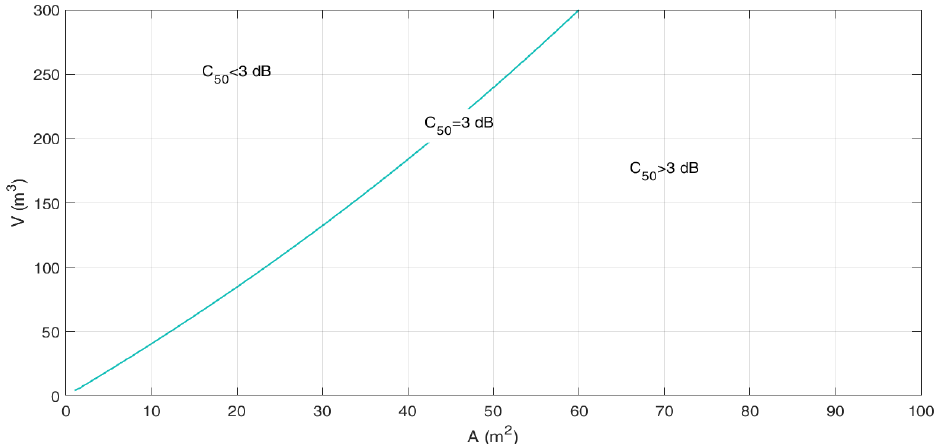
Figure 4. Prediction A – V Diagram: contour line for C 50 = 3 dB, which divides the graph into two zones, one for C 50 < 3 dB and the other for C 50 > 3 dB.